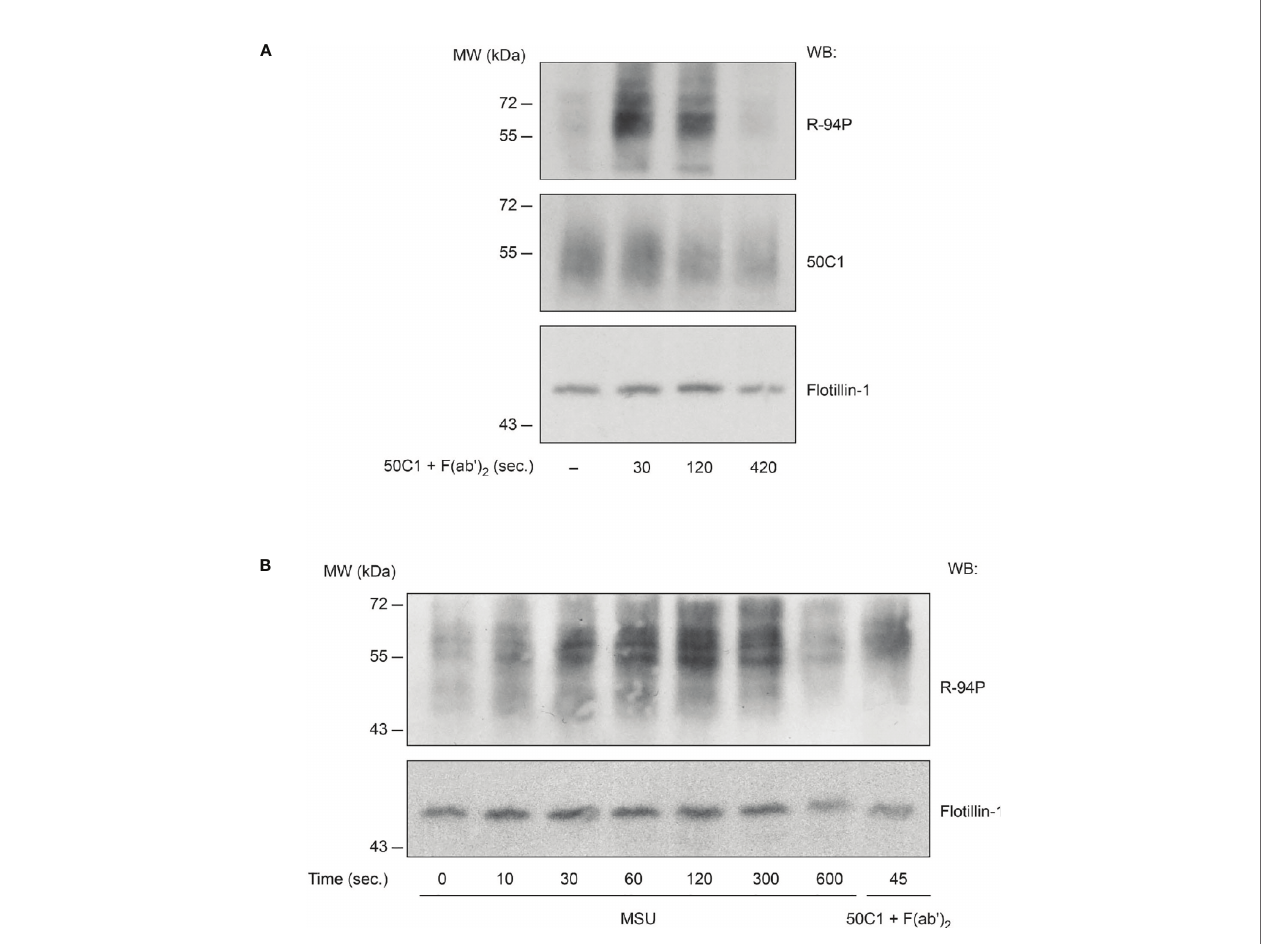
FIGURE 4 | CLEC12A phosphorylation upon antibody-induced cross-linking and MSU stimulation in human neutrophils. (A) Cell-surface CLEC12A was cross-linked with 50C1 on human neutrophils prior to immunoblotting plasma membrane preparations with R-94P, 50C1 or fl otillin-1 ( loading control ) antibodies. Data are representative of 3 independent experiments. (B) Plasma membranes isolated from MSU-stimulated neutrophils were immunoblotted with R94P or fl otillin-1. For comparison, CLEC12A was also cross-linked as in (A) for 45 seconds. Data are representative of 3 independent